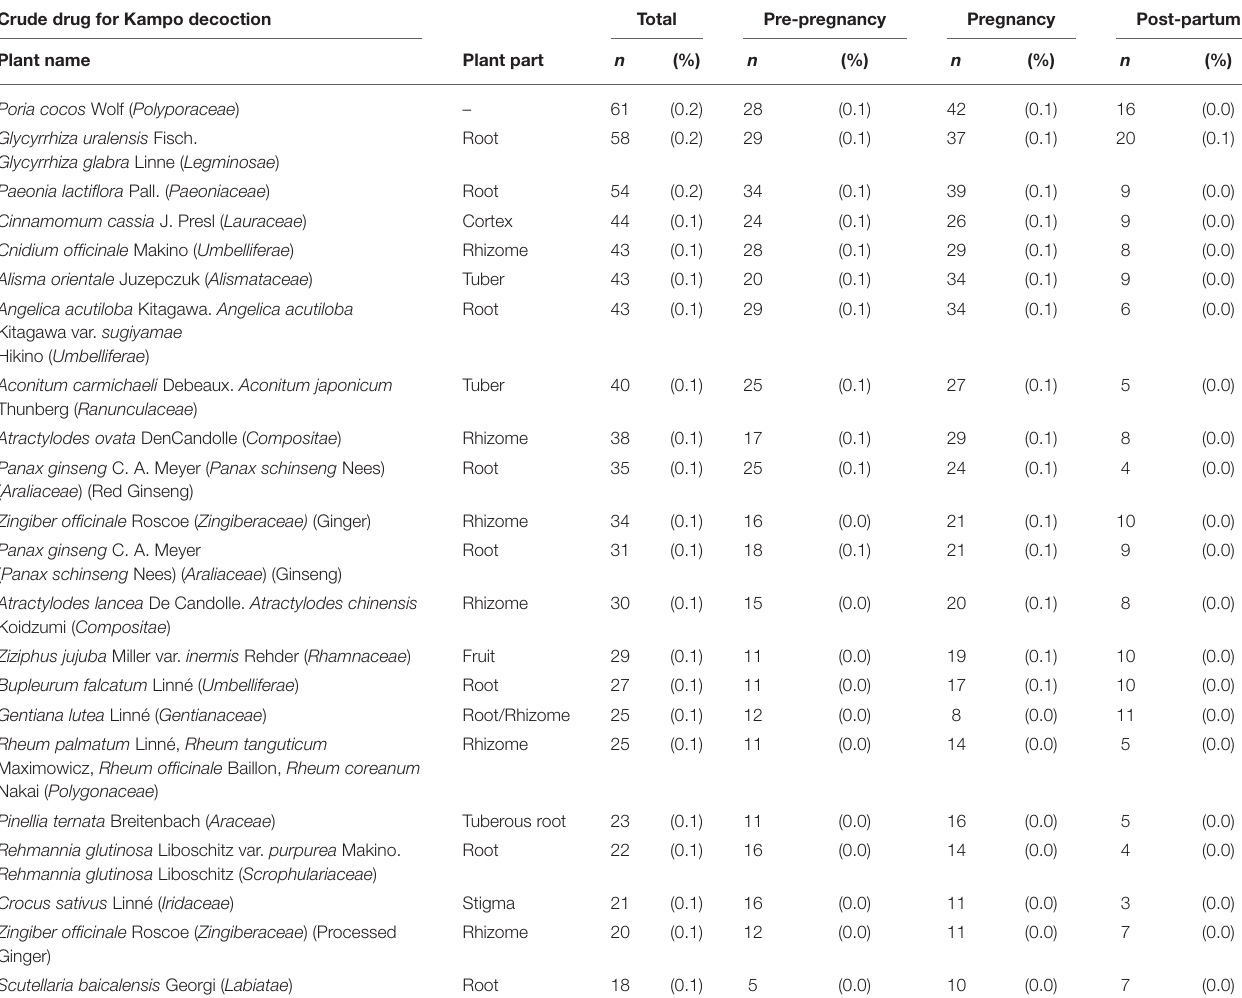
TABLE 2 | The prescription status of crude drugs used in decoctions (those with a prescription frequency of 0.1% or more). Crude drug for Kampo decoction Total Pre-pregnancy Pregnancy Post-partum Plant